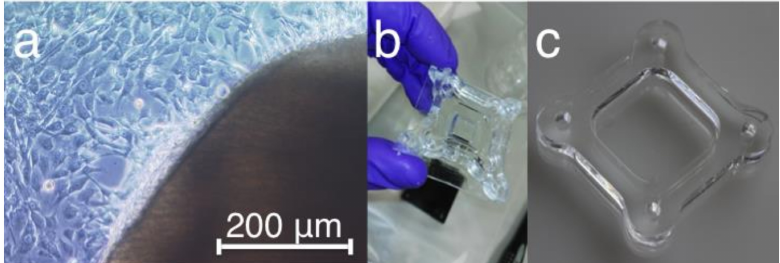
Figure 7. Primary tenocytes and poly(dimethylsiloxane) (PDMS) chamber. ( a ) Cell migration 2 weeks after the Achilles tendon explant cultivation. The light microscopic image of a rat Achilles tendon fragment from which predominantly tenocytes emigrate is shown. ( b ) PDMS elastomeric stretching chambers in mold after polymerization and ( c ) after removal from the mold. The inner area of the stretching chambers has a size of 2 × 2